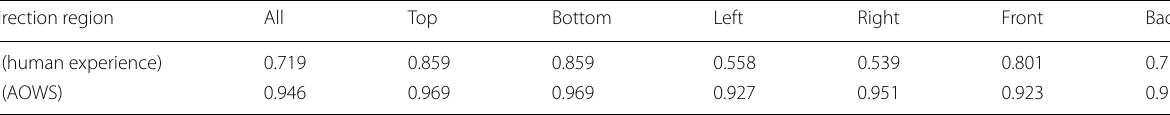
Table 2 Thrust drivability of static object holding mission Direction region All Top Bottom Left Right Front Back D (human